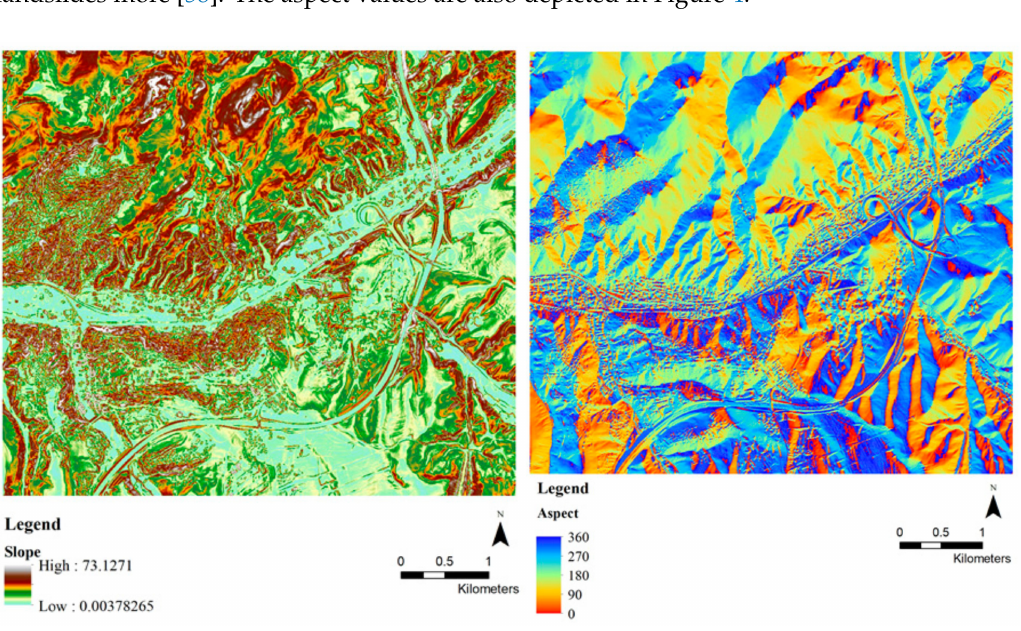
Figure 4. The slope gradient ( left ) and aspect ( right ) maps of the study